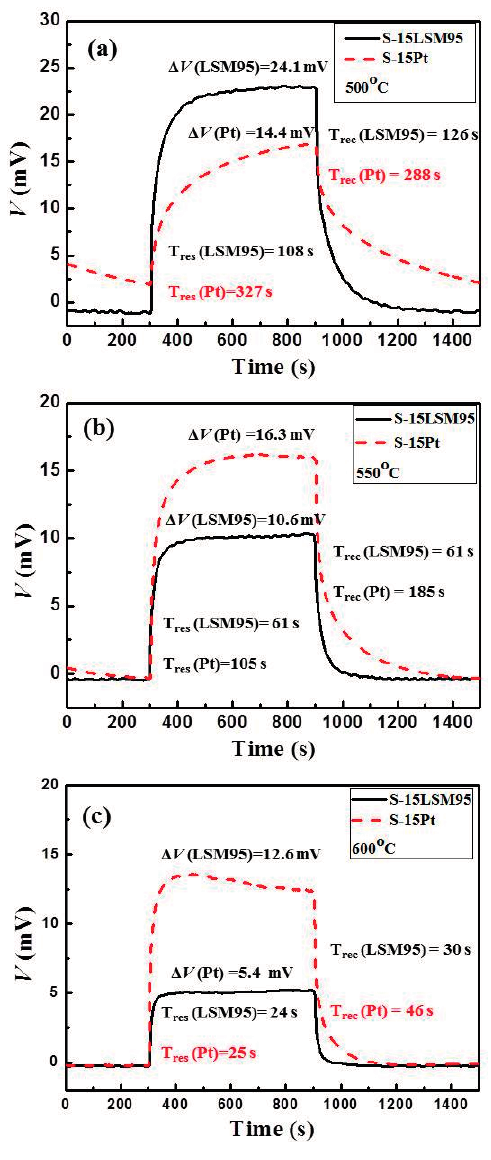
Figure 10. Response curves of S-LSM95 and S-Pt measured in the base gas and sample